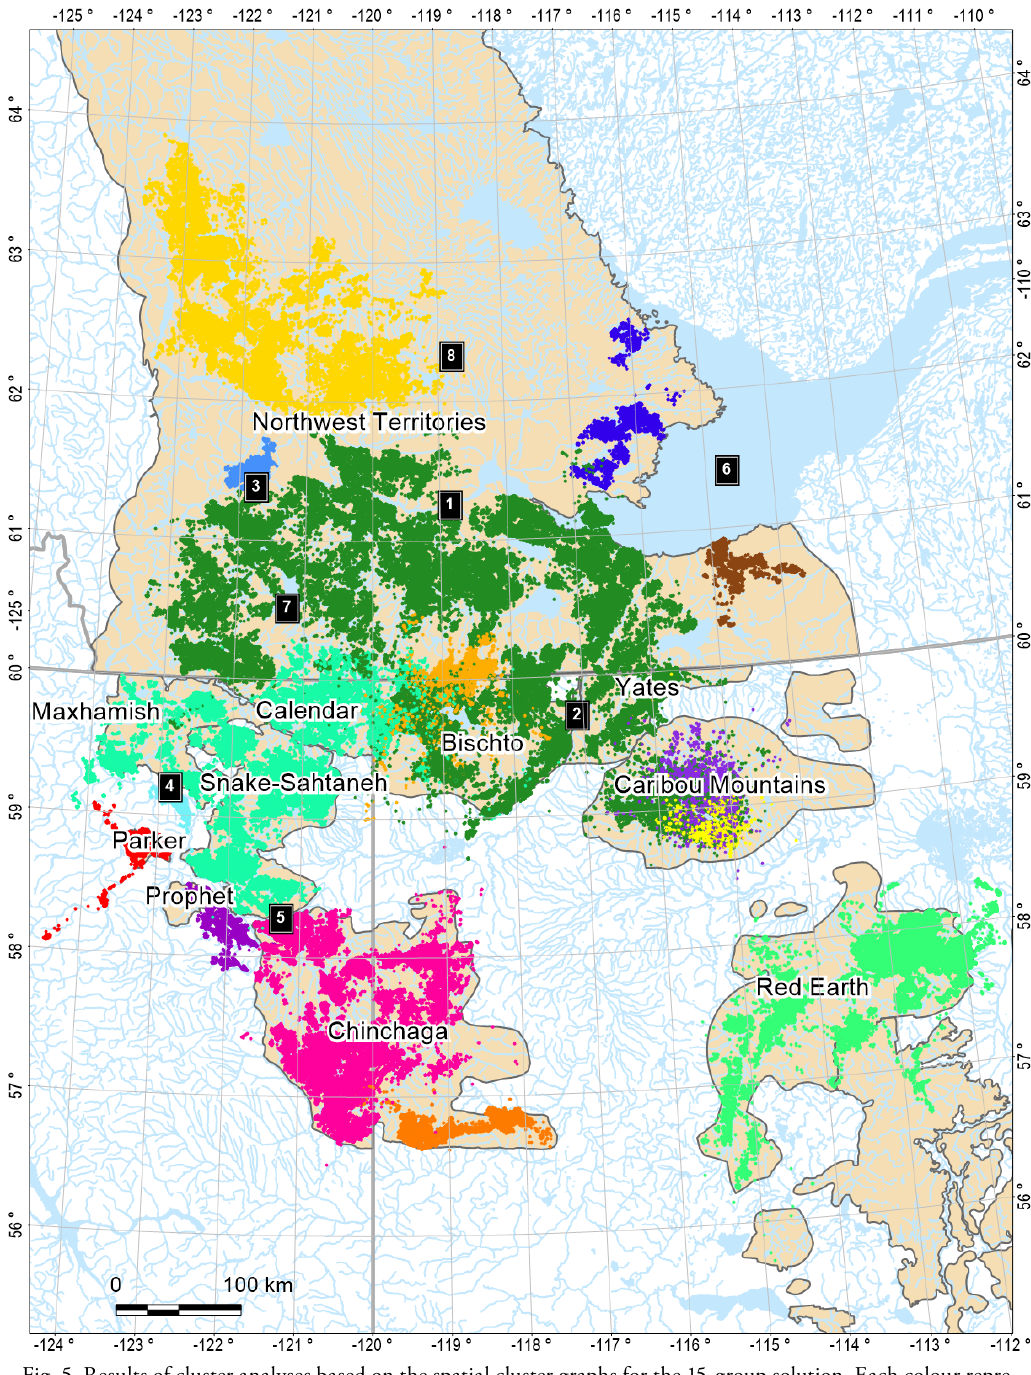
5. Results of cluster analyses based on the spatial cluster graphs for the 15-group solution. Each colour repre- sents a distinct group. See Figure 4 caption for definition of feature